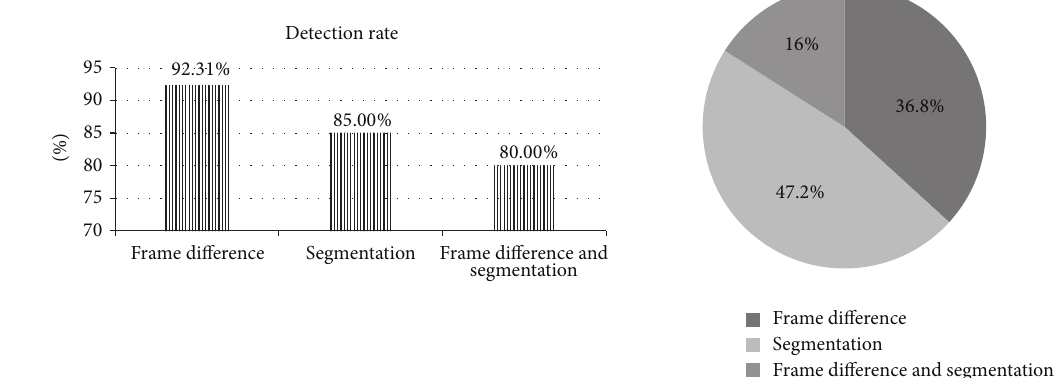
Figure 2: Detection rate [1, 15, 36, 40] and percentage of using frame difference and segmentation approach in the previous research.